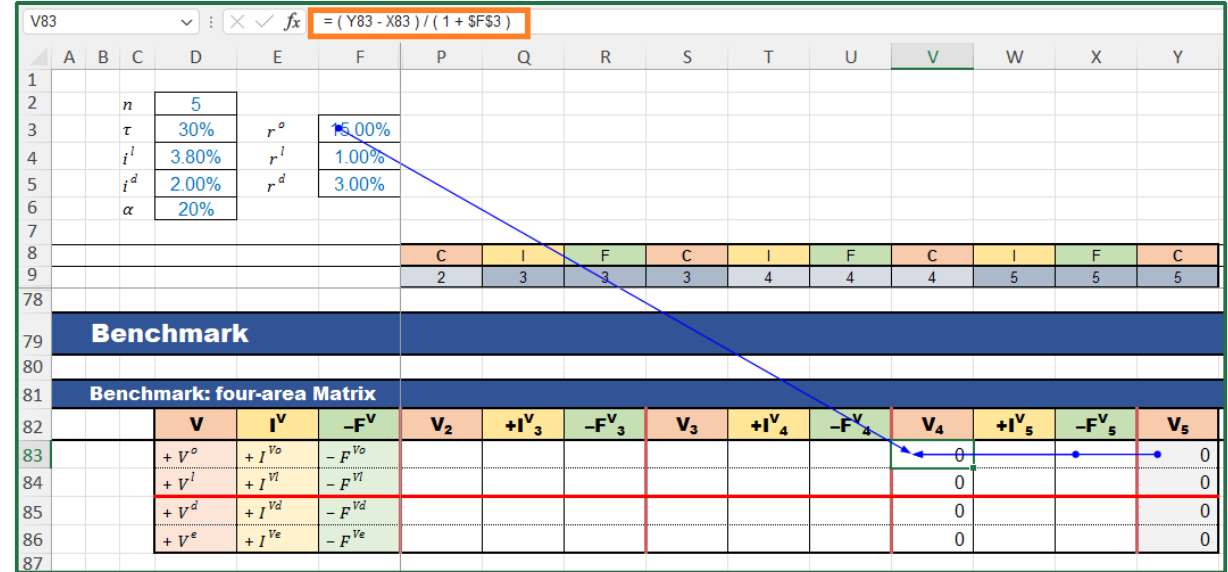
Figure 32. Cell V83 contains the formula for calculating the economic value 𝑉 (cid:2872)(cid:3042) as a function of next-period value 𝑉 (cid:2873)(cid:3042) and cash flow 𝐹 (cid:2873)(cid:3042) (“SplitScreenStrip” sheet).